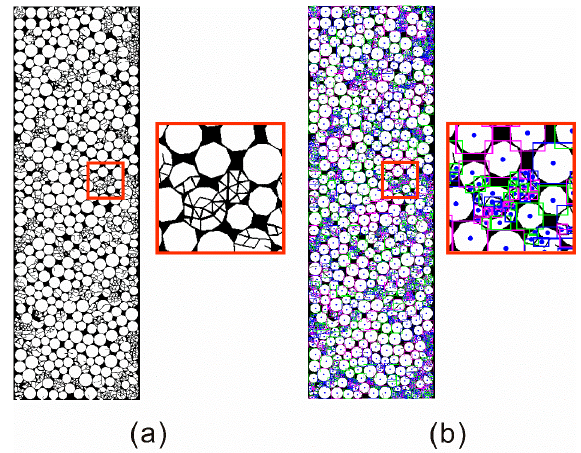
Figure 8. Details of the method to obtain the particle area distribution. ( a ) The original image of the filled particles; ( b ) The processed picture after each polygonal particle was marked by a rectangle with a dot in the center.